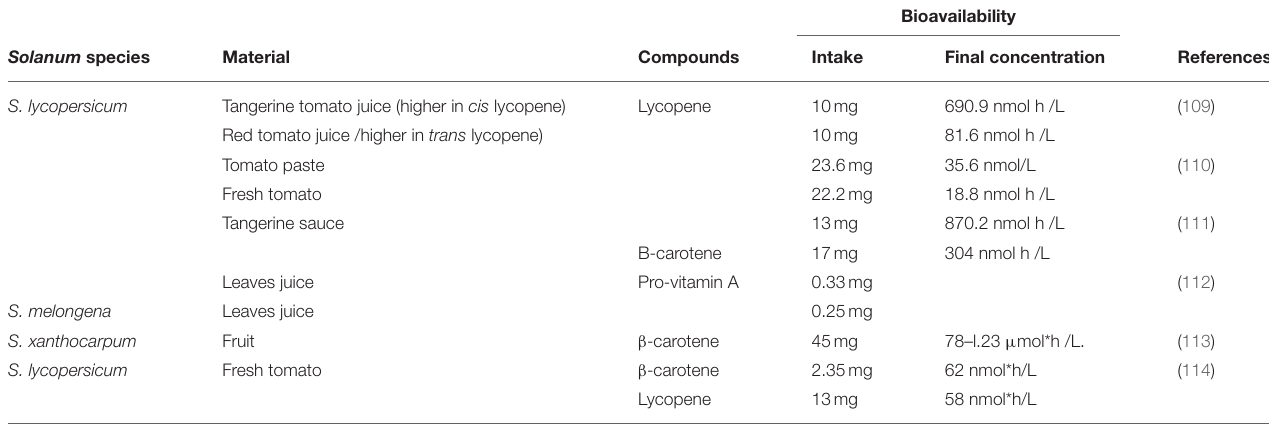
TABLE 2 | Bioavailability of compounds in Solanum